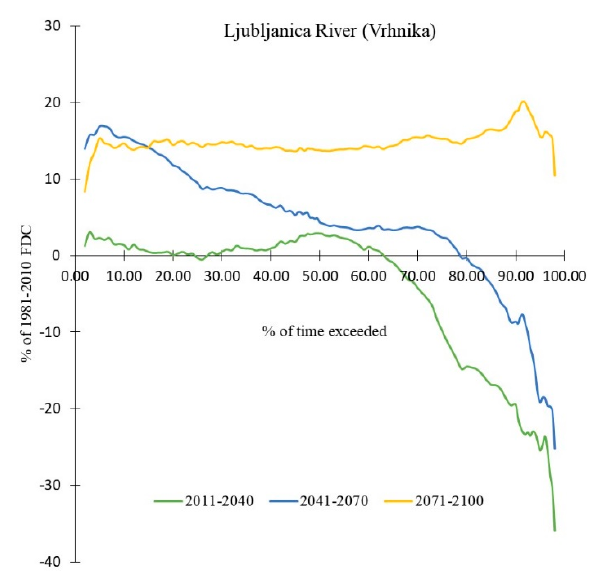
Figure 6. Flow duration curve (Q2–Q98) comparison for the three investigated periods where the median curve is shown for the Vrhnika station (Ljubljanica River).